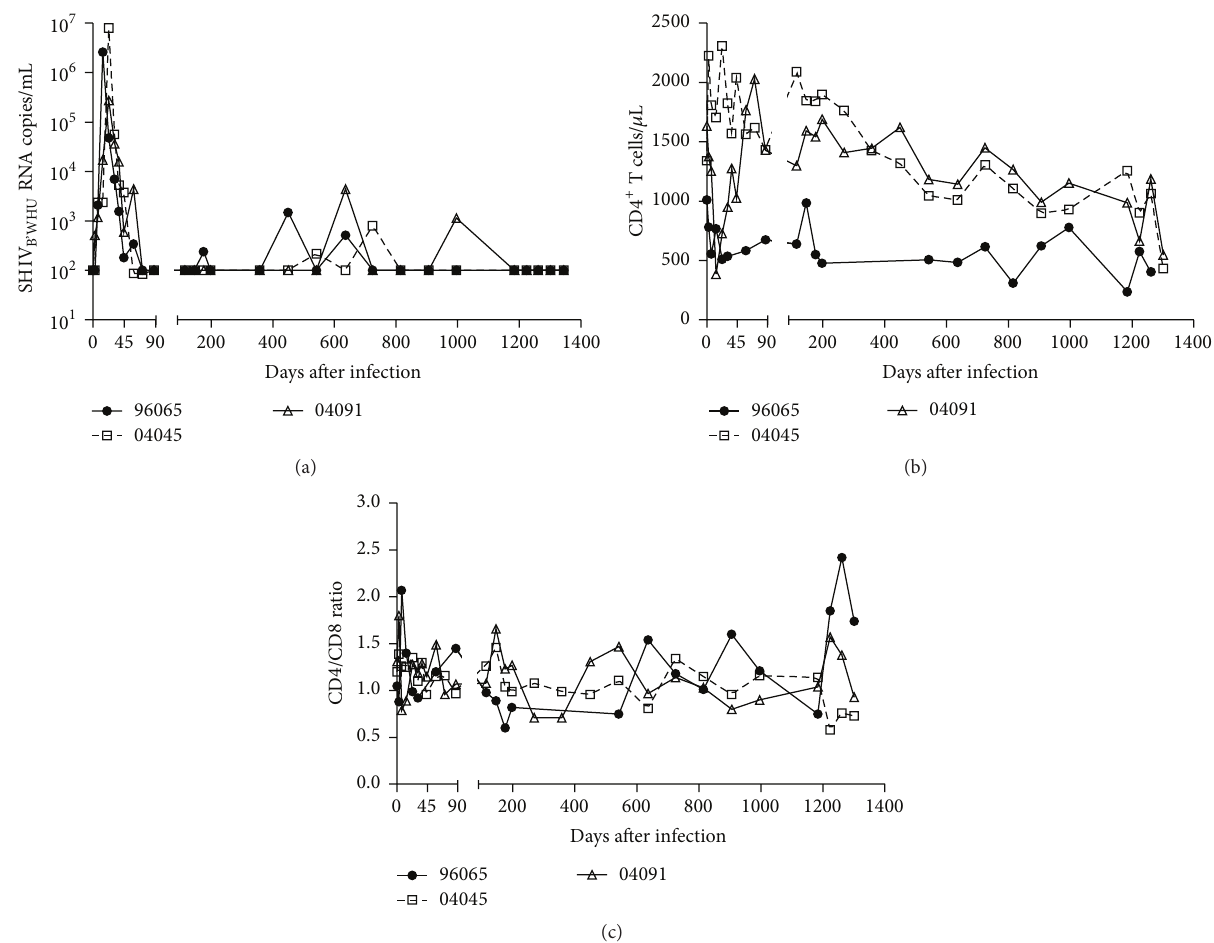
Figure 1: Dynamics of virologic and immunologic parameters of SHIV indicates the limit of detection at 100 copies/mL plasma. (b) CD4 + T cells. (c) Ratio of CD4 + to CD8 + T